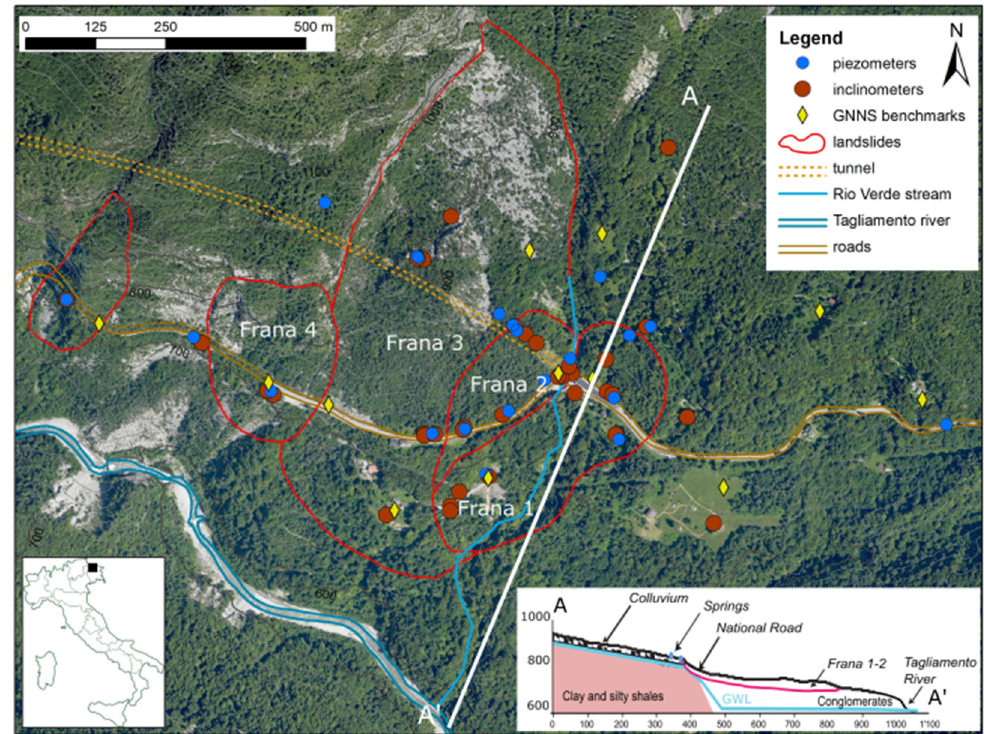
Figure 1. The Passo della Morte area with the monitoring devices installed during the last 20 years. In the right-hand corner, a hydrological cross-section of the slope.